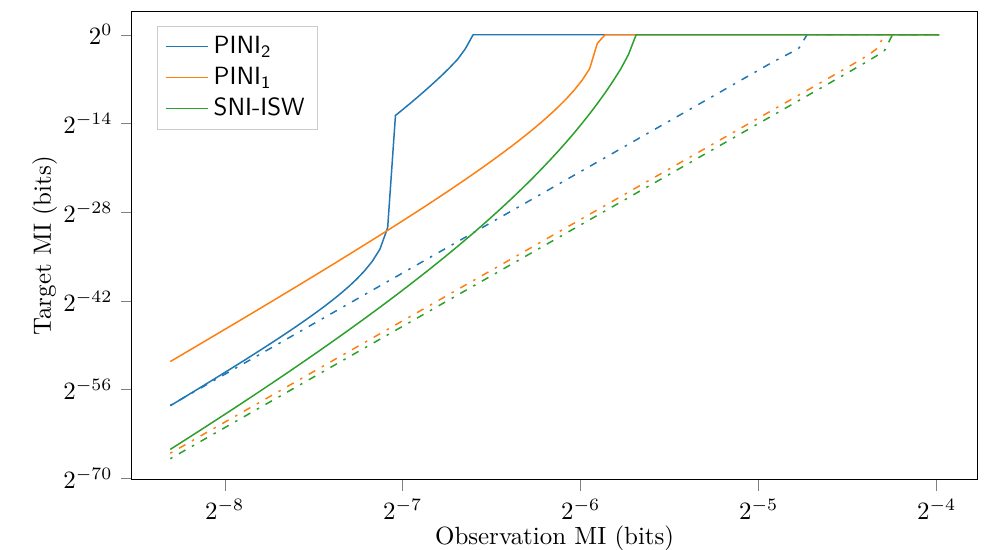
Figure 4: Target MI as a function of observation MI, for the SNI-ISW multiplication gadget [ISW03], the PINI 1 multiplication gadget [CS18] and the PINI 2 gadget (Section 3). The continuous line is the result of the belief propagation algorithm for the MI and the dashed line is a lower bound for the target MI computed assuming only the leakage on input shares are exploited. Results are shown for order